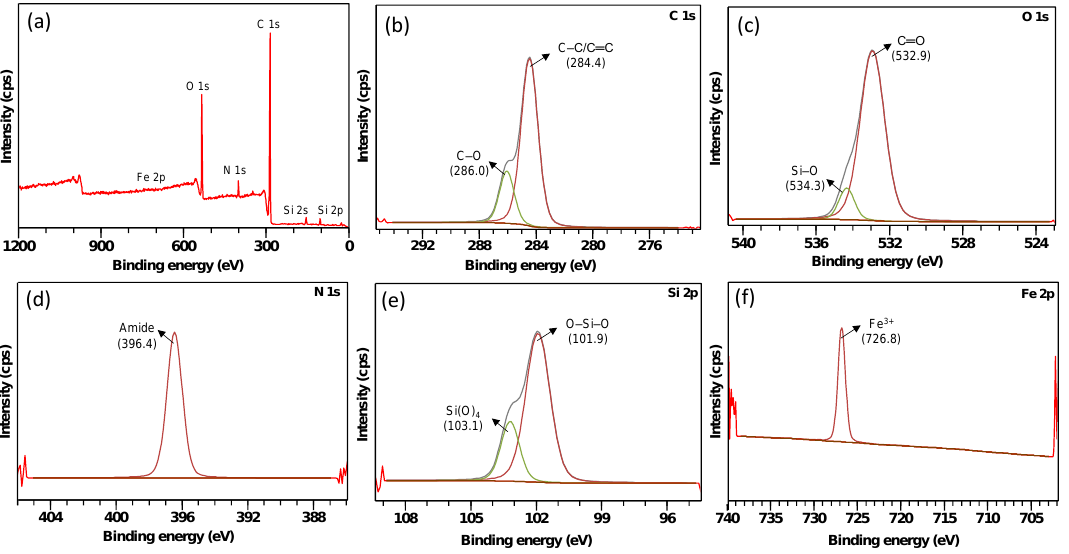
Figure 3. ( a ) XPS survey spectrum and high-resolution spectra of ( b ) C 1s, ( c ) O 1s, ( d ) N 1s, ( e ) Si 2p, and ( f ) Fe 2p of FMS/PU composite adsorbent.